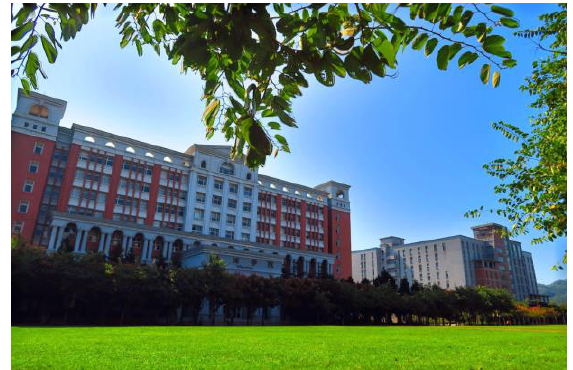
Figure 2. Case study building: College of